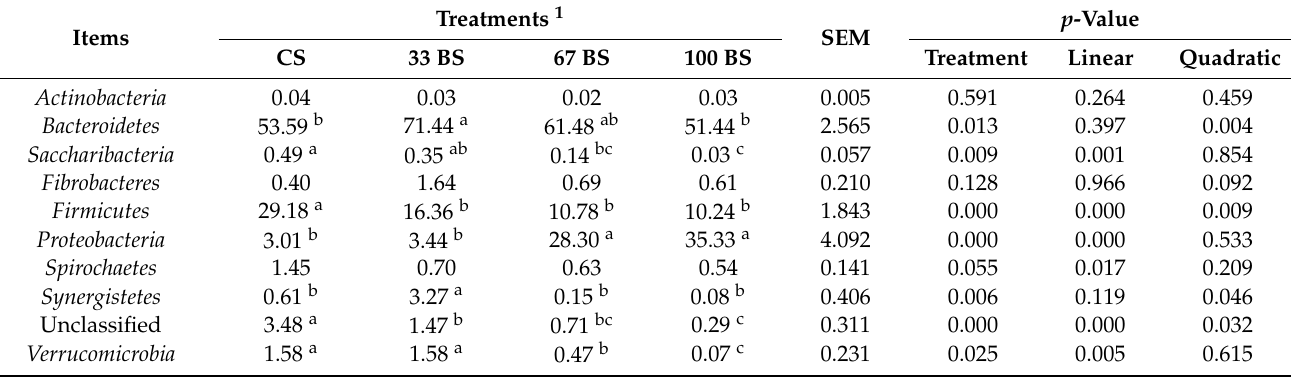
Table 5. Effects of dietary barley starch levels on relative abundances of dominant phyla at 2 h after morning feeding in the rumen of Hu